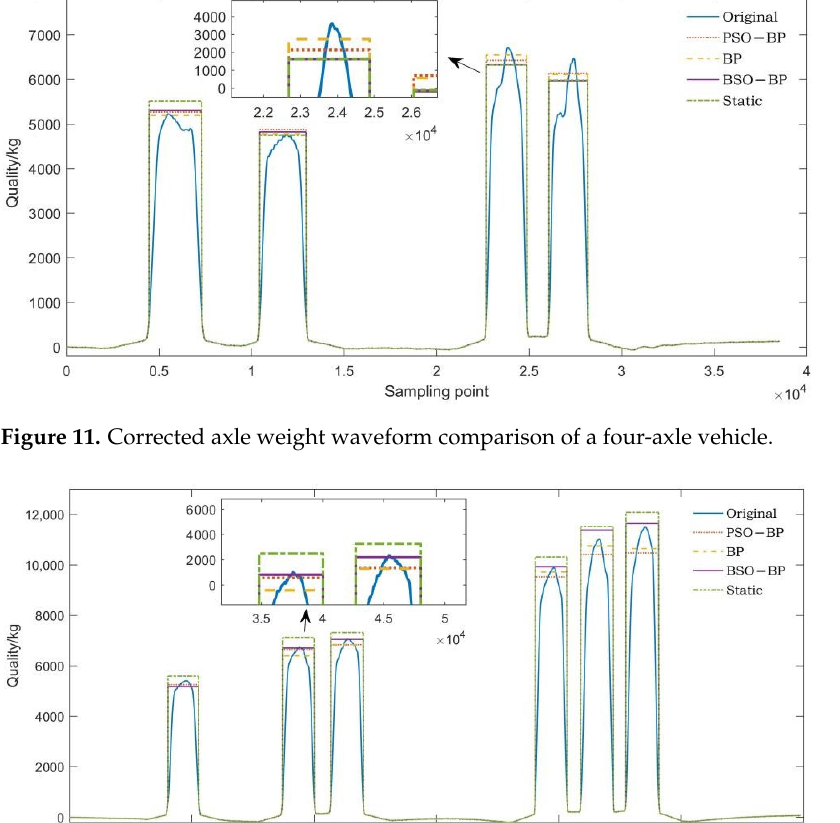
Figure 10. Corrected axle weight waveform comparison of a two-axle vehicle.